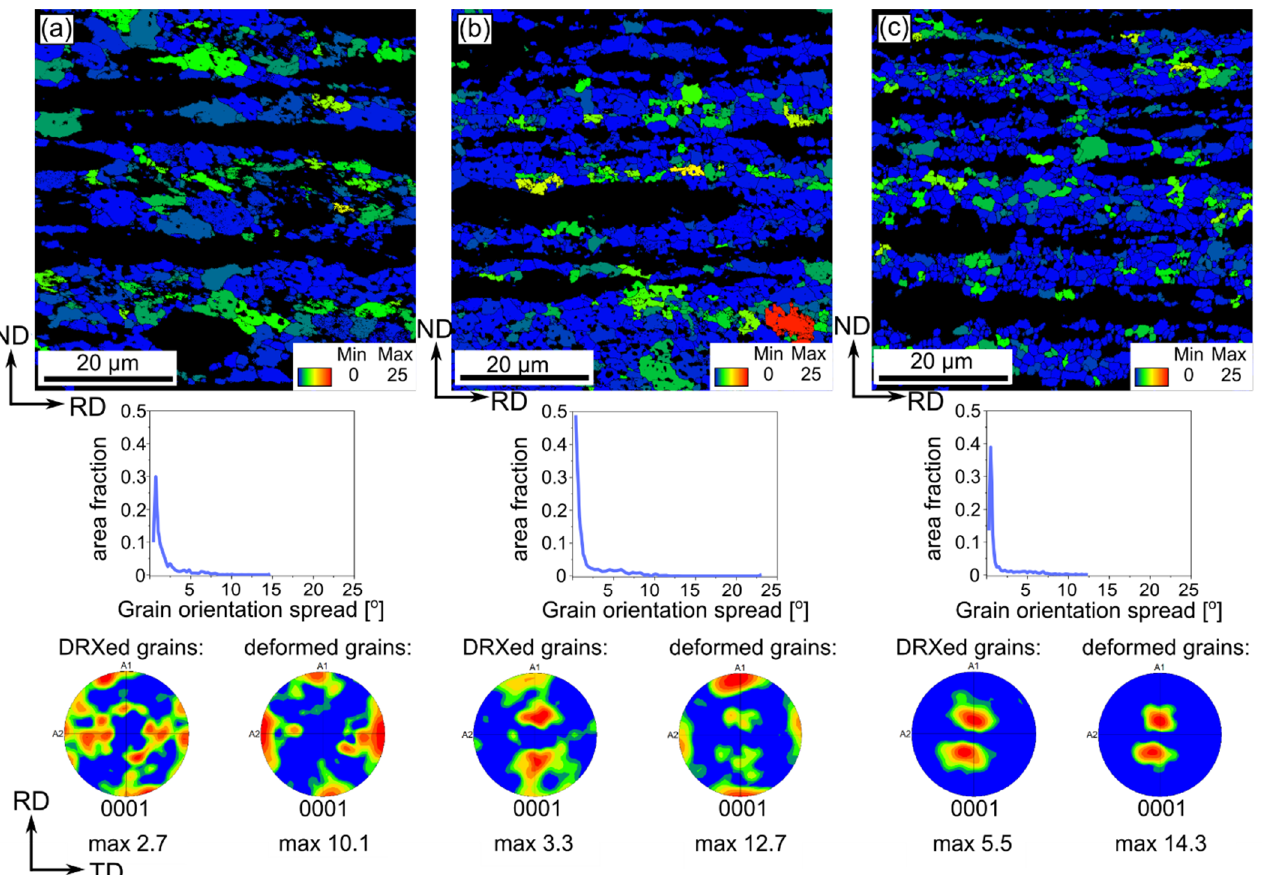
Figure 8. GOS maps with the parameter distribution and below (0001) pole figures of separate based on GOS parameter fraction of DRXed grains (GOS ≤ 5°) and deformed grains (GOS > 5°) of the cold-rolled Zn-5Cu alloy with the reduction rates of 50% ( a ), 75% ( b ) and 90% ( c ). Table 1. List of microstructural characteristics of cold-rolled Zn-1Cu and Zn-5Cu alloys.